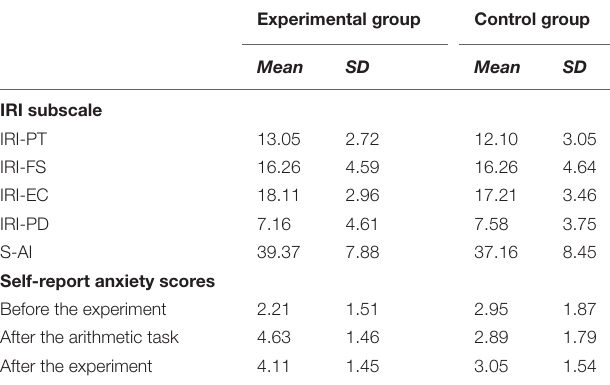
TABLE 1 | Descriptive statistic for the subscales (IRI and S-AI) and self-report anxiety scores in the experimental group and the control